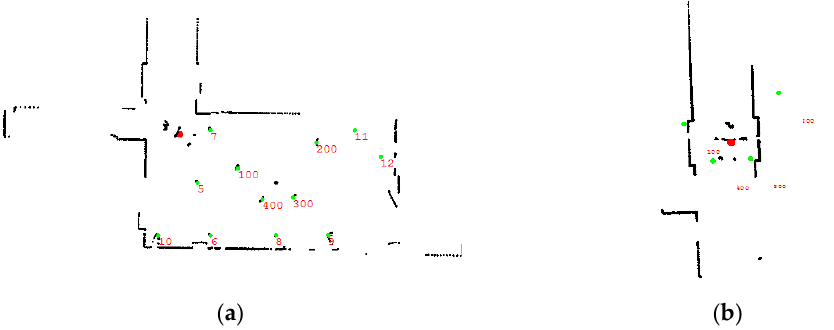
Figure 13. System real-time navigation map: ( a ) normal navigation mode; ( b ) navigation mode failure in the corridor.